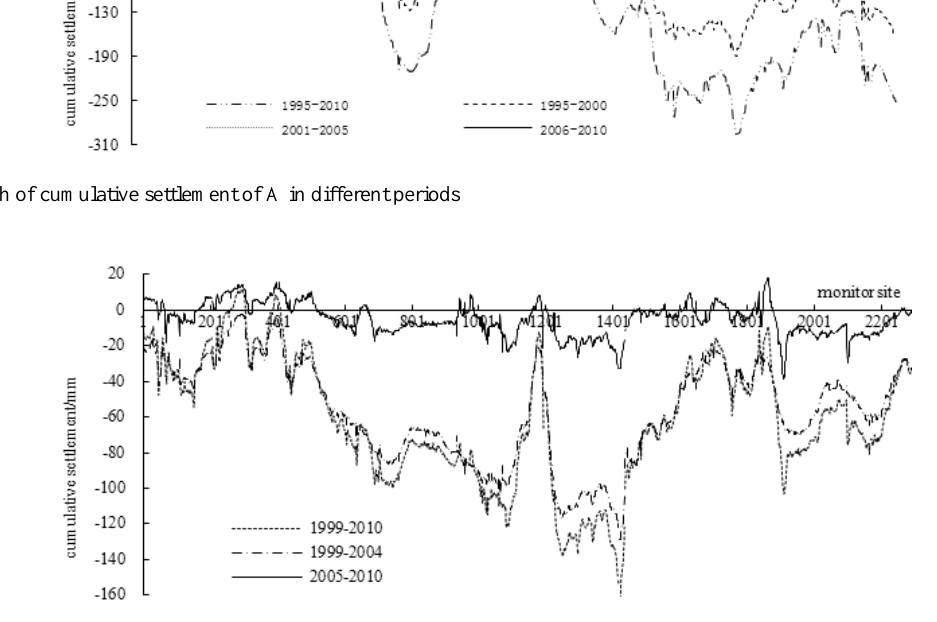
Figure 2. Graph of cumulative settlement of B in different periods.